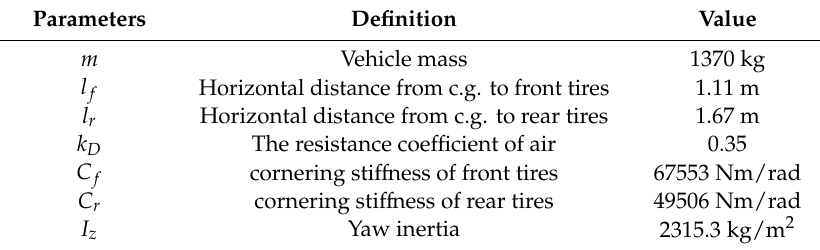
Table A2. Symbols and definitions of the dynamics model